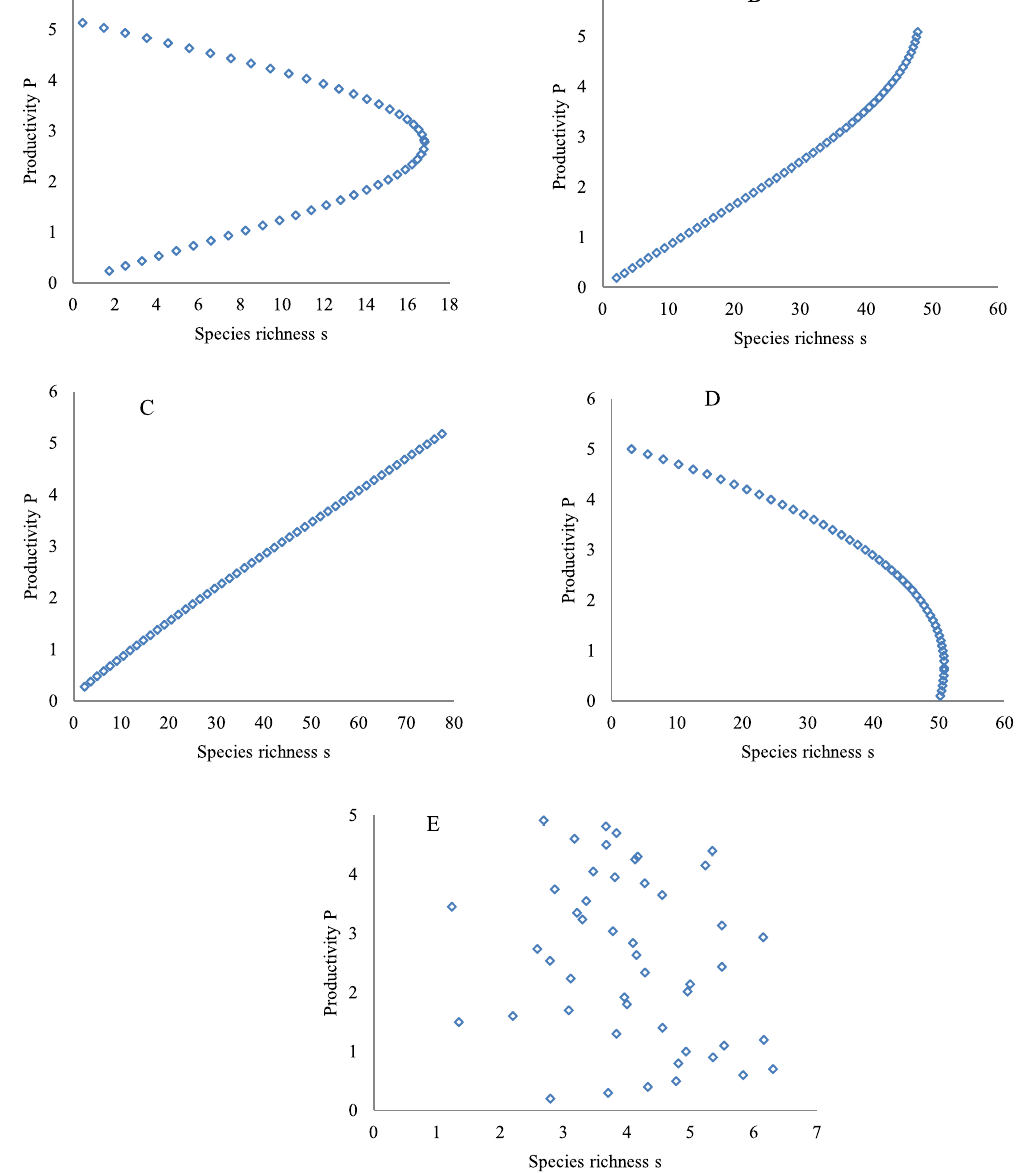
Figure 3. The SRPR with s continually presenting non-monotonic increases. These figures were created based on the calculation results of Eq. 10, i.e., species richness as inputs to Eq. 21 to calculate plant productivity for a transformation of dependent variables and independent variables. ( A1 – E1 ) show the humped, positive, asymptotic, negative and irregular forms, respectively, generated by substituting the derived species richness in Fig. 1A1–E1 into Eq.